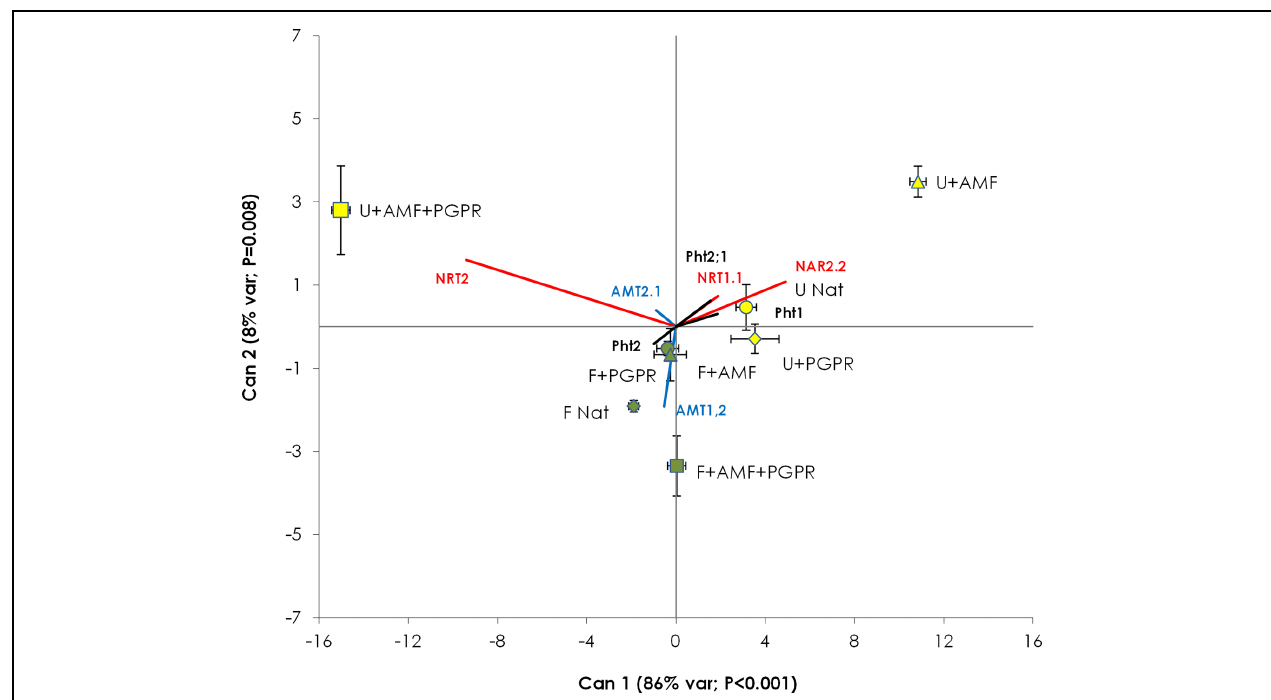
FIGURE 4 | Canonical discriminant analysis constructed with the gene expression data of T. durum root. Percentage of total variance explained by each canonical axis is shown in parentheses. Percentages of variance explained by Can 3 to Can 7 were not significant (data not shown). Plants were grown under the unfertilized conditions (U, yellow symbols) or fertilized with an organic fertilized with low C:N ratio (F, green symbols). Soil was left with the NAT (circles); inoculated with only AMF spores (triangles); only plant PGPR (diamonds), or both AMF + PGPR (squares). Nitrate transporters vectors are shown in red, AMTs vector in blue and phosphorus transporters vector in black. Each symbol represents the treatment centroid within Can 1 and Can 2. Bars represent the standard error of the distribution of each